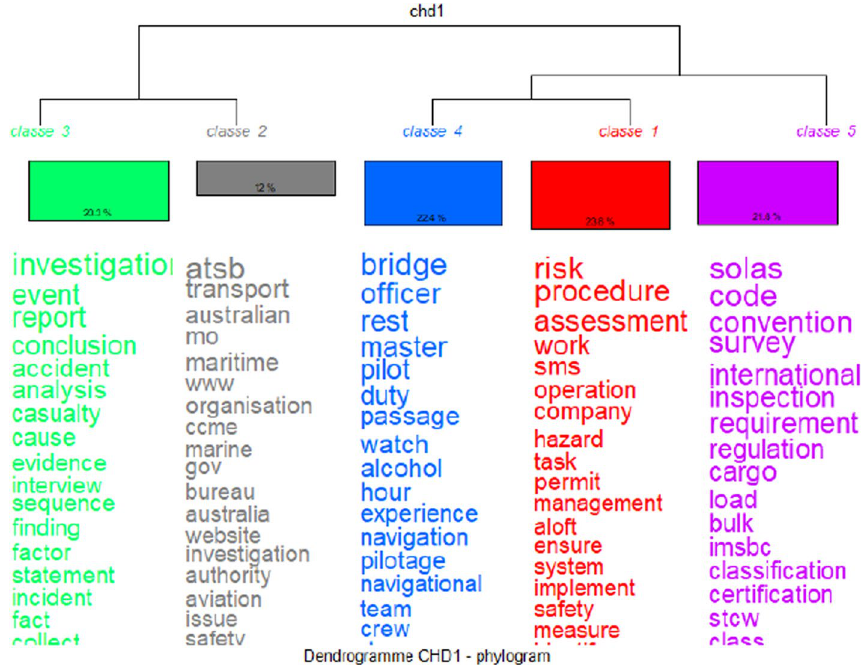
Fig. 5 Dendrogram of clusters extracted from the sub‑corpus of cluster 1 and associated word extracts (DHC) in IMO dataset. (* Cluster is reported as Classe in IRAMUTEQ dendrogram). Source: The